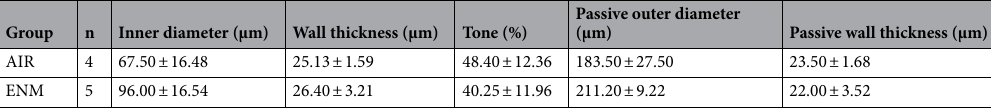
Table 2. Coronary arteriole characteristics. Coronary arteriole characteristics in Sham-control and ENM groups. Values are shown as mean ± SEM. Statistics were analyzed with a students T-test ( p < 0.05).